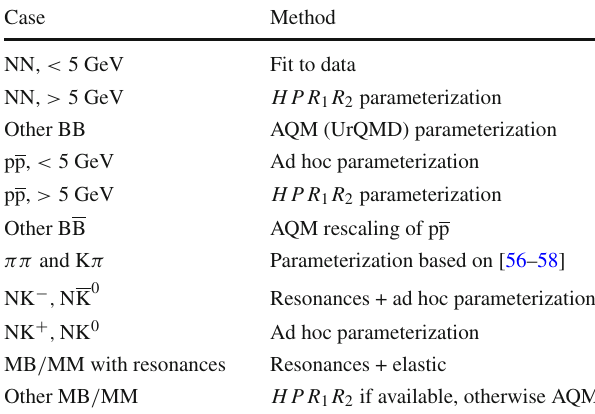
Table 1 Summary of total cross section descriptions. Here, N is used to denote a nucleon (p or n), B a baryon and M a meson